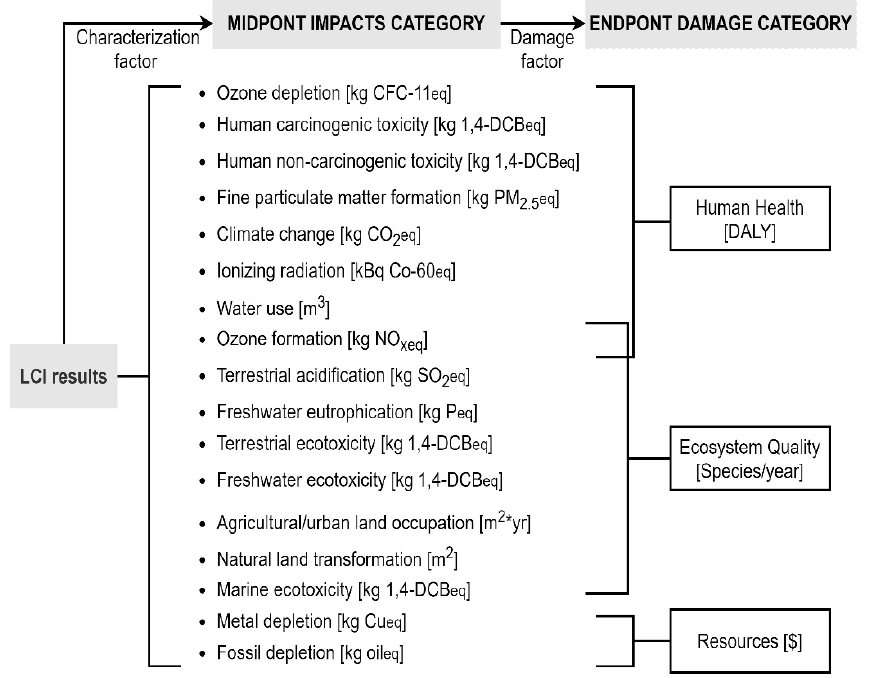
Figure 9. Scheme of the ReCiPe 2016 framework, emission from [63] .